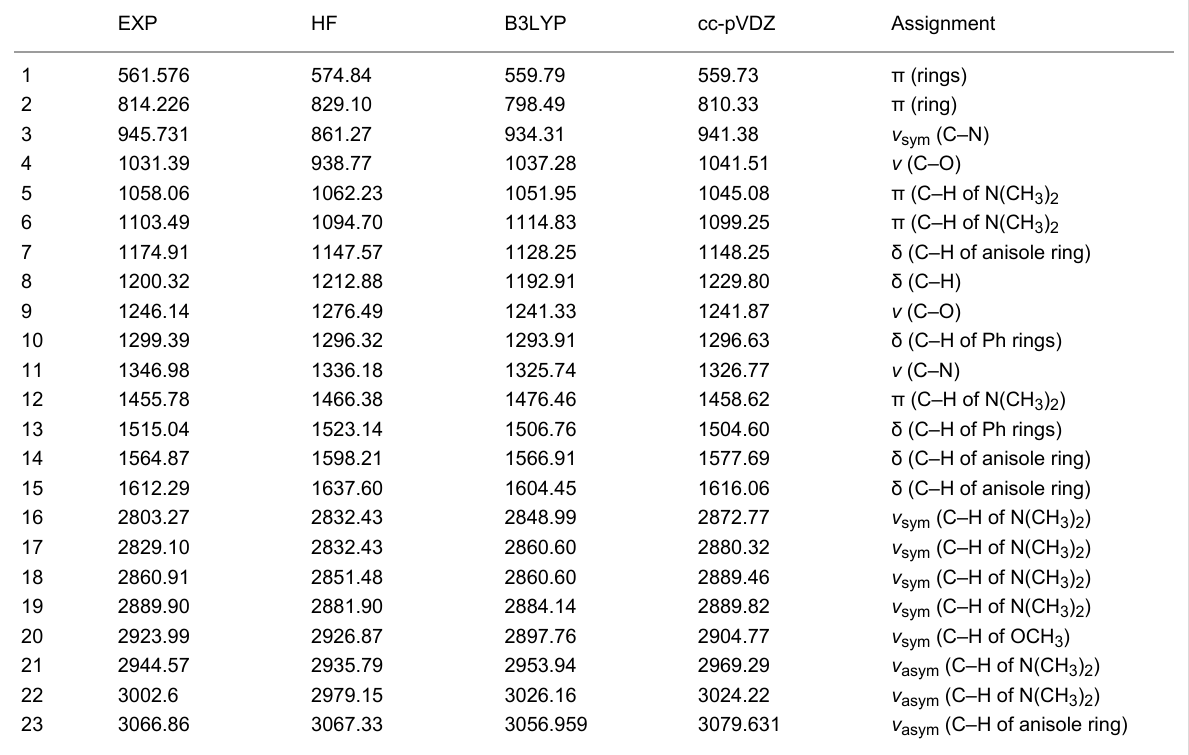
Table 3: Comparison of the observed and the calculated vibrational wavenumbers (cm − 1 ) of compound 11 ( ν , stretching; δ , in-plane bending; π , out- of-plane bending; ω , wagging. Subscript: asym: asymmetric; sym: